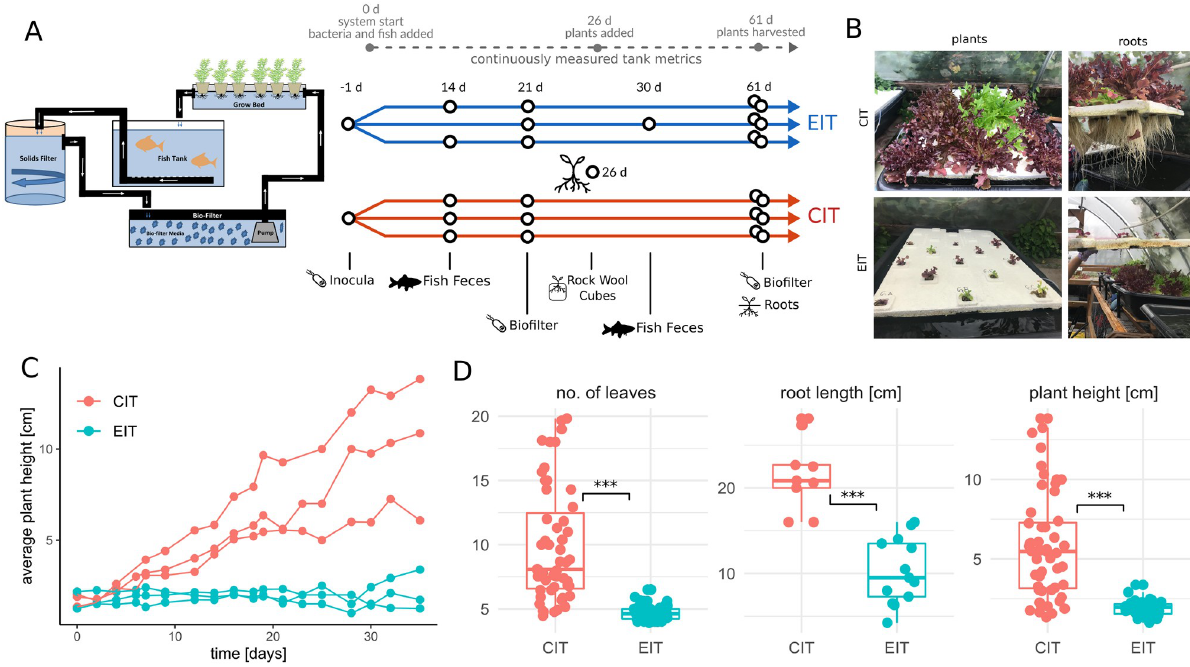
Fig 1. Aquaponic system design and plant phenotypes. (A) Aquaponics sampling timeline and system design. Left shows aquaponics system design and right sampling strategy. Gray circles on top denote experimental events and every black empty circle denotes a single sample. One fish feces sample could not be extracted at day 14 and was resampled at day 30. (B) Representative images of L . sativa plants and roots after a month of growth in systems with different inocula. (C) Plant growth over time. Each dot denotes the average plant height for a single aquaponic system taken at the indicated time point. Measures from the same tank are connected by lines. Gray line denotes growth in the prior aquaponics system that was used as the source for EIT. (D) Plant growth measures by inoculum. Each point denotes an average value measured in a single tank at a single time point (n = 104, 22, 105 for leaves, root length, and plant height, respectively). Stars denote significance under a Mann-Whitney U test (all p < 0.001).